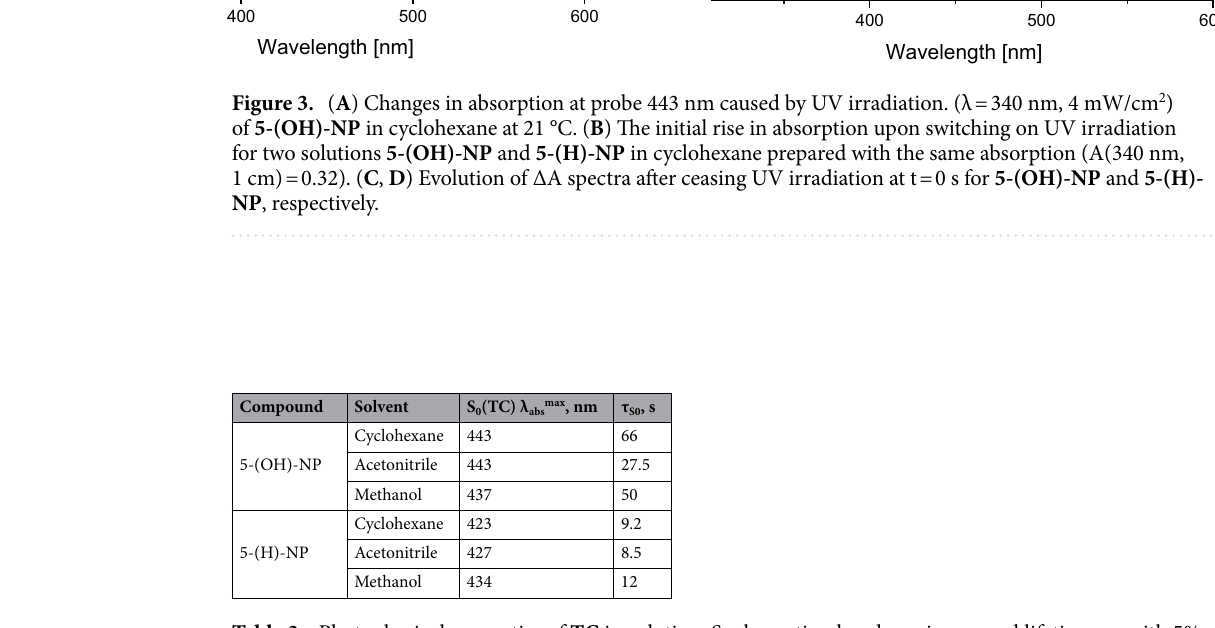
Table 3. Photophysical properties of TC in solution: S 0 absorption band maximum and lifetime τ S0 with 5% accuracy (at 21 °C).